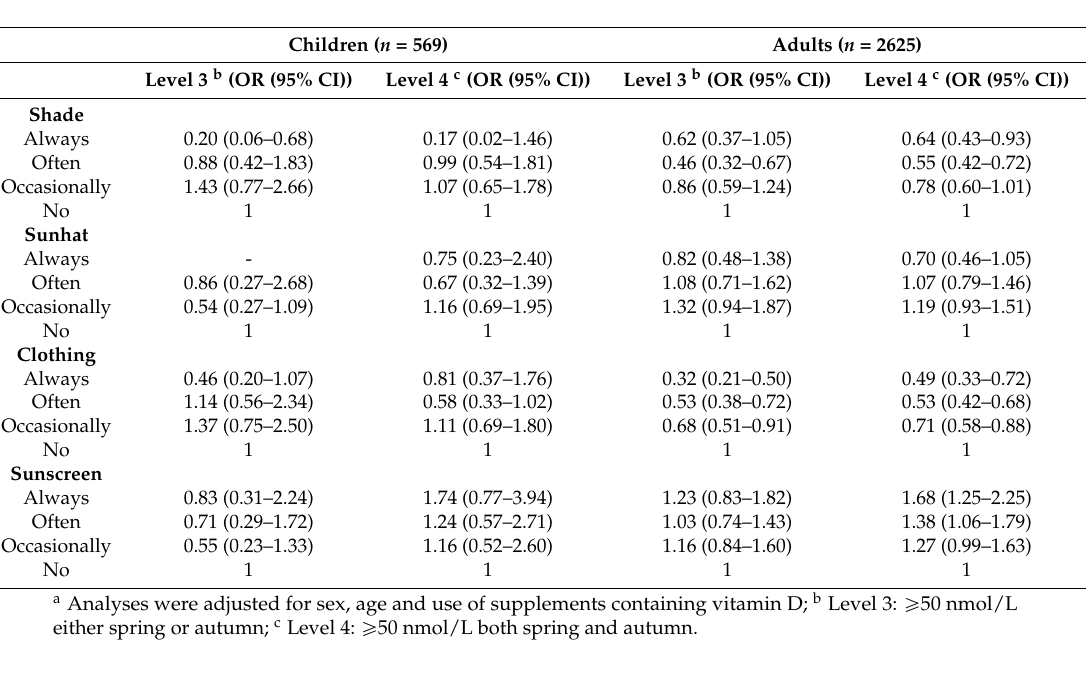
Table 4. Adherence to sun exposure guidelines in relation to odds ratio (OR) of having adequate/high vitamin D status a .